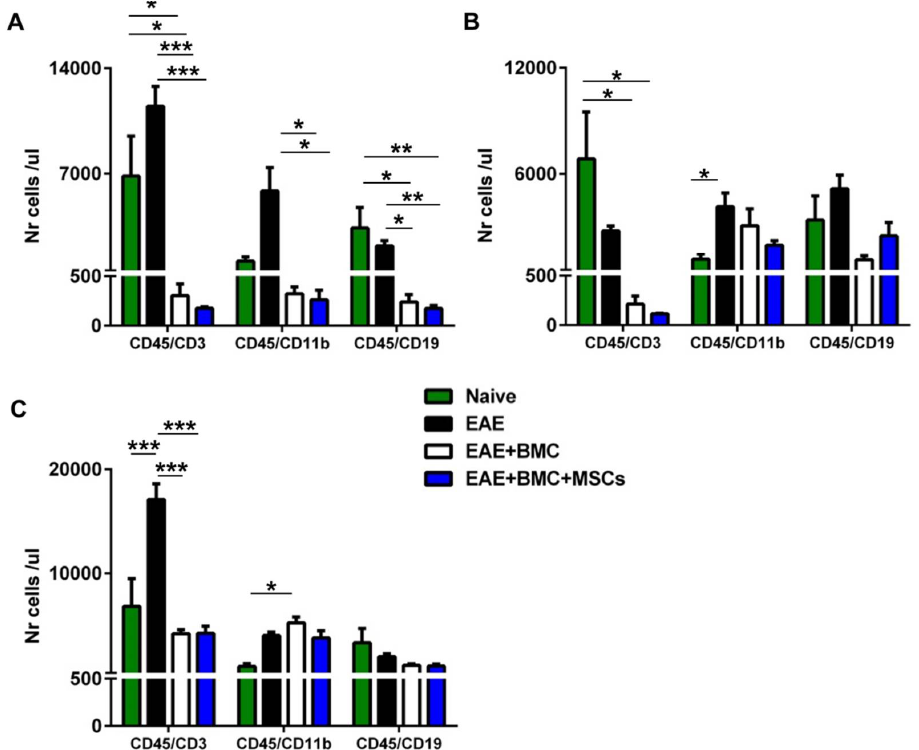
Figure 3. Injection of MSCs together with HSCs does not enhance immune cell engraftment. Quantification of immune cells performed by counting the absolute number/μL of EDTA-treated peripheral blood of T cells (CD3), monocyte/macrophages (CD11b) and B cells (CD19) at: ( A ) 3 days after TBI, ( B ) 12 days after TBI, and ( C ) 33 days after TBI. Quantitative data are presented as mean ± SEM of CD45-gated cells with n = 3 mice per group. * p < 0.05, ** p < 0.01, *** p < 0.001.